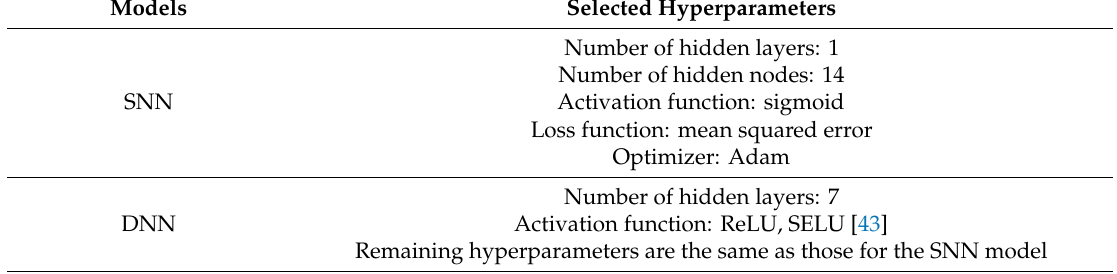
Table 2. Selected optimal hyperparameters for each deep learning model.